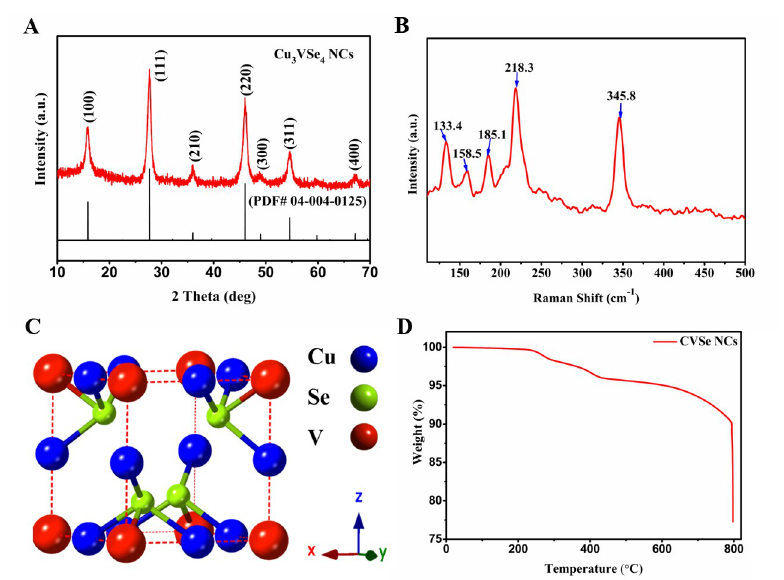
Fig 1. Characterization of CVSe NCs. (A) X-ray diffraction. (B) Raman spectrum. (C) Crystal structure. (D) TGA plot of synthesized CVSe